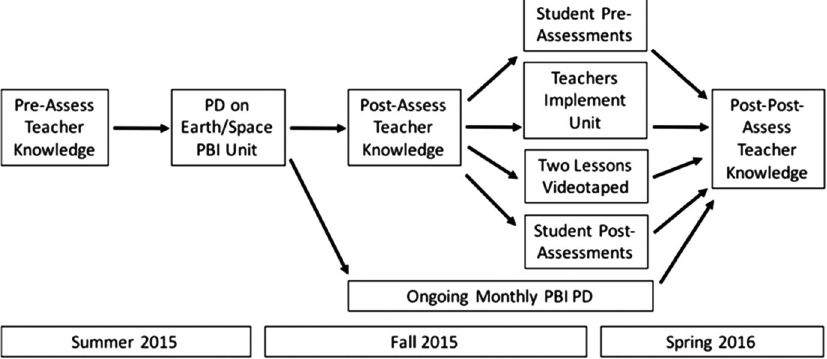
FIG. 1. Flowchart of data collection and professional development with teachers.